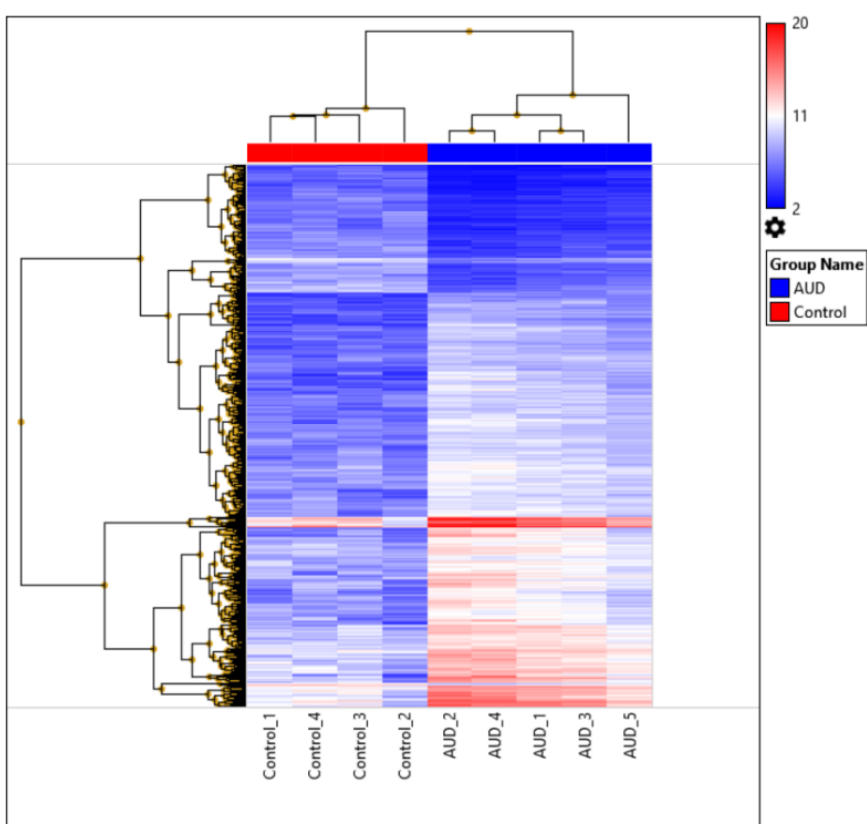
Figure 2. Heatmap of the 931 most significantly differentially expressed genes in the thalamus (FDR < 0.01 and Fold Change ≥ ± 2). Clear distinction between the alcohol use disorder (AUD) group and controls is evident by the gene expression profiles in the dorsomedial thalamus. The legend represents fold change based on linear data.